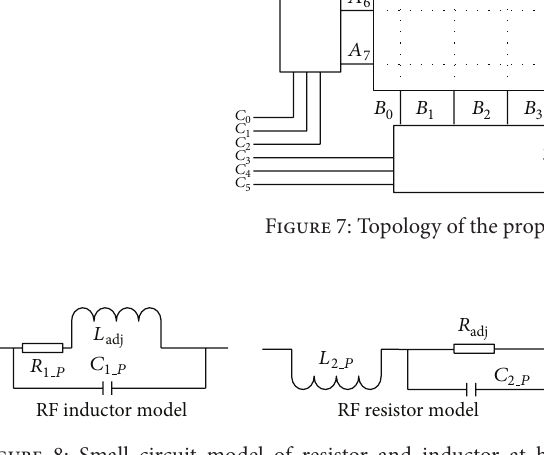
Figure 8: Small circuit model of resistor and inductor at high frequency.